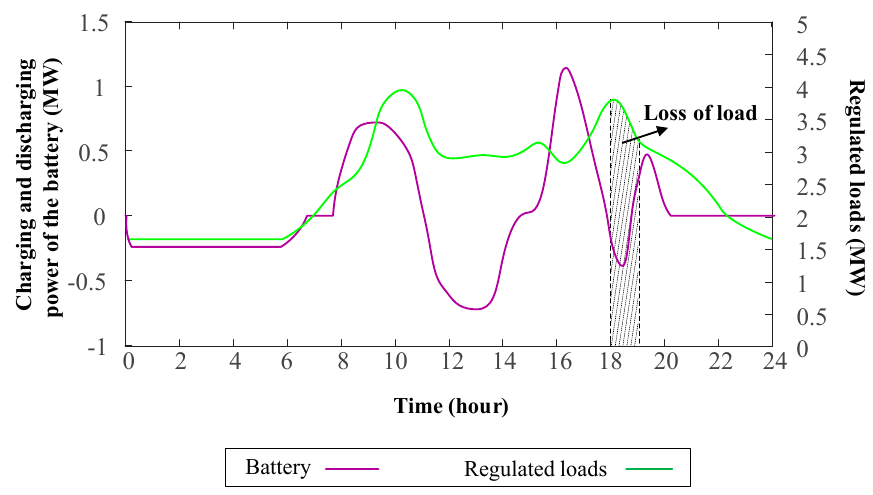
Figure 7. Real-time battery output power (positive represents discharging) and regulated loads (“regulated loads” is defined as “original loads minus hybrid energy system output”).